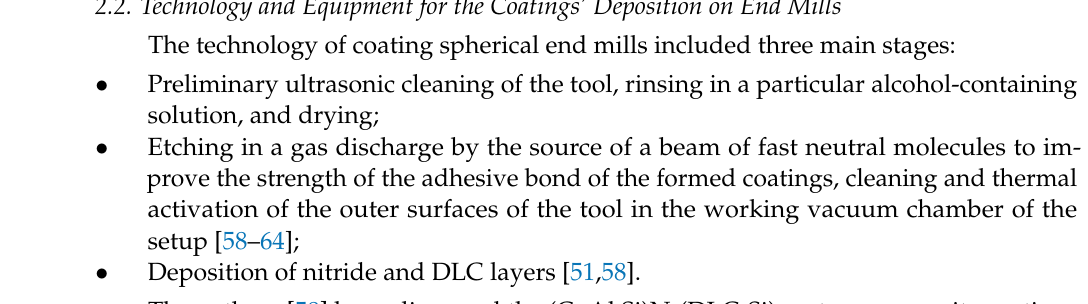
Table 2. Chemical composition of XH45MBTJuBP alloy used in research.